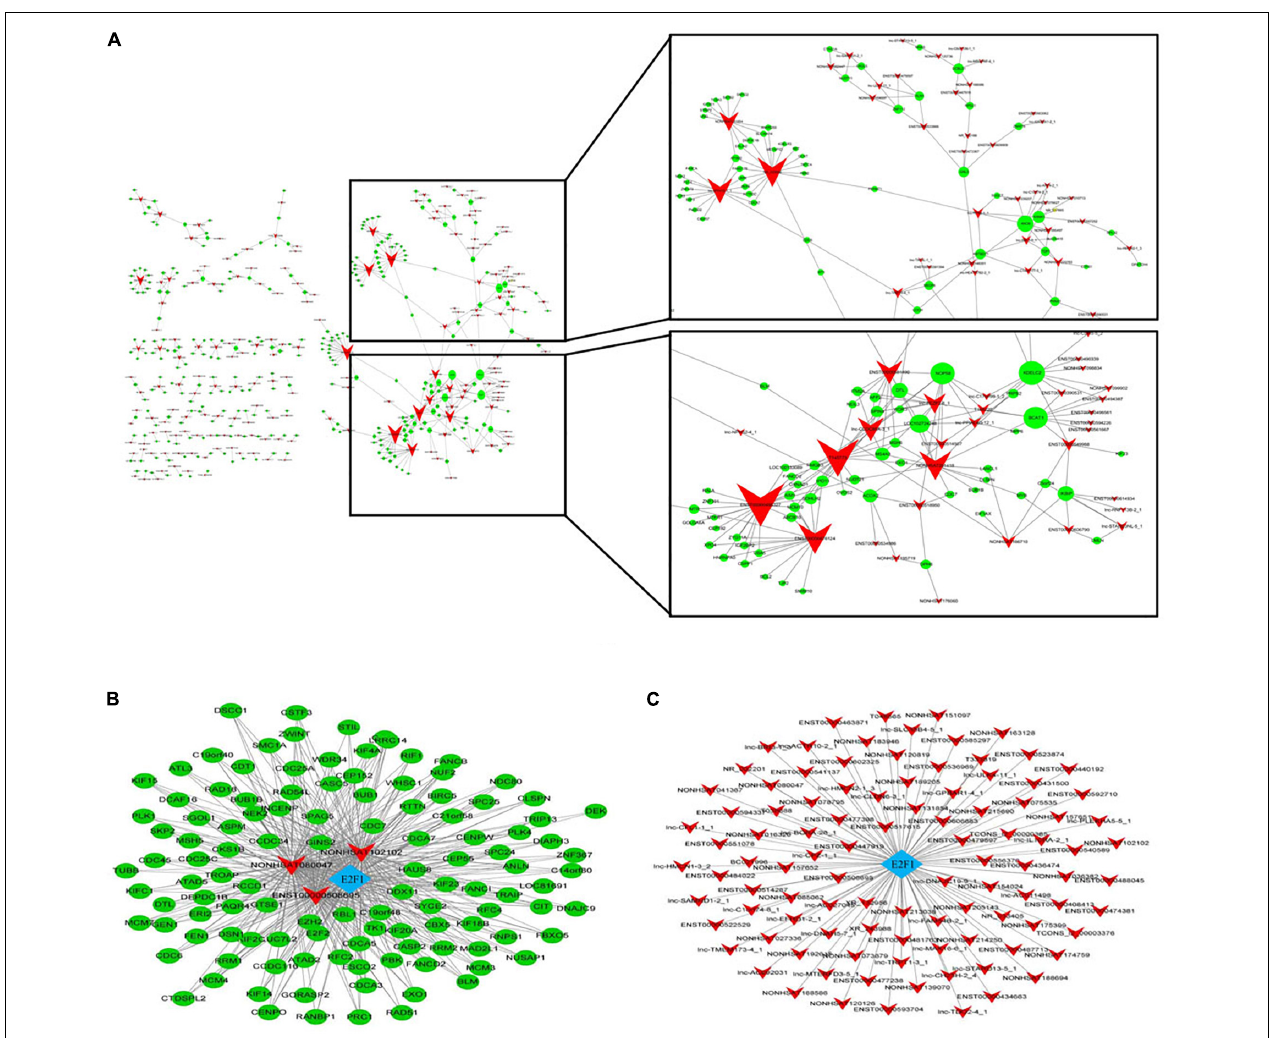
FIGURE 3 | Construction of the lncRNA-mRNA co-expression network. Circle and square nodes represent mRNAs and lncRNA, respectively. The sizes of circle nodes are proportional to the number of interacting lncRNA. (A) Core network map constructed based on the 500 most significantly correlated lncRNA/mRNA pairs. (B,C) Correlation analysis between lncRNA and TFs. Arrow, rhombus, and circle nodes represent lncRNA, TFs, and target genes, respectively. (B) Network map of the top 200 lncRNA/TF pairs. The size of rhombus nodes is proportional to the number of interacting lncRNA. (C) Network map of the top 200 lncRNA/TF/target gene interactions. The sizes of rhombus and circle nodes are proportional to the number of interacting TFs and lncRNA,